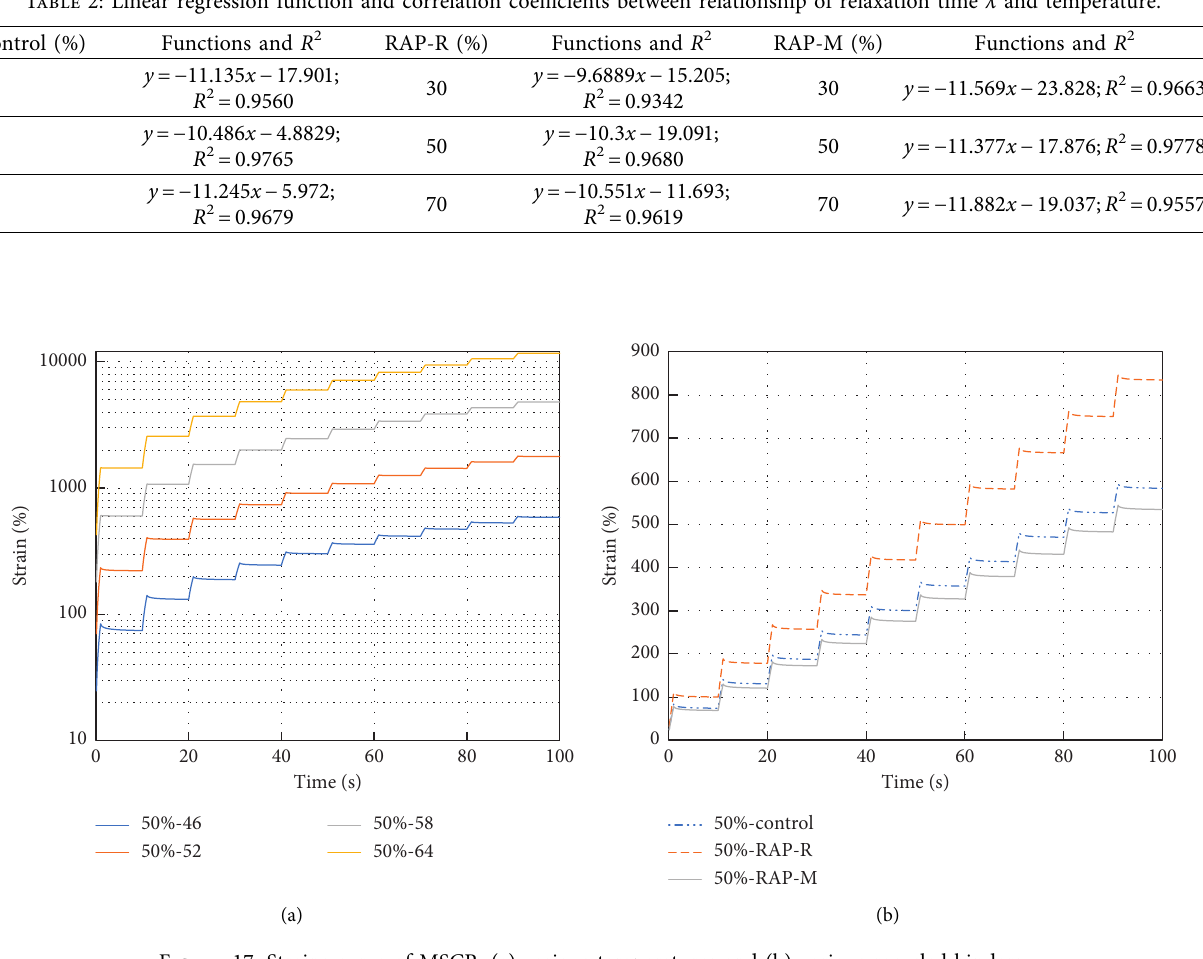
Figure 17: Strains curve of MSCR: (a) various temperatures and (b) various recycled